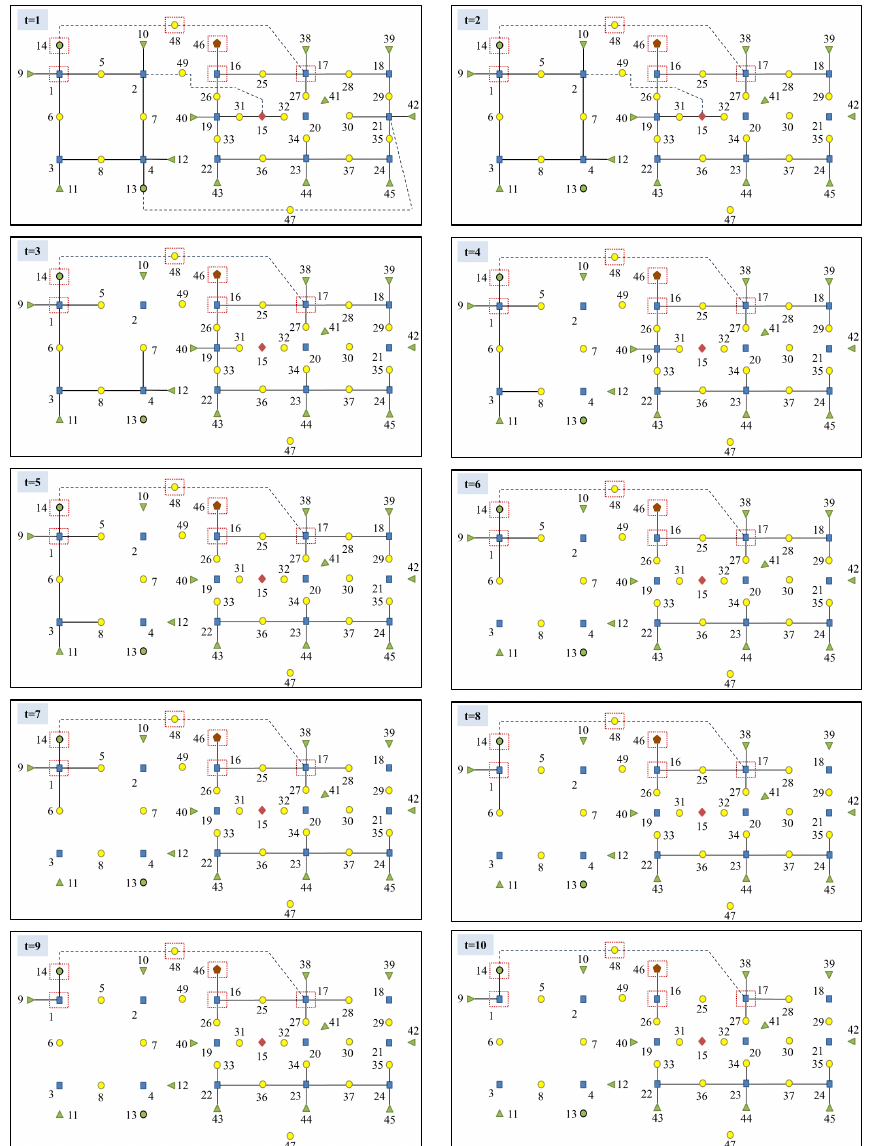
Figure 6. Evolution process of coupled electric power and gas networks using the proposed